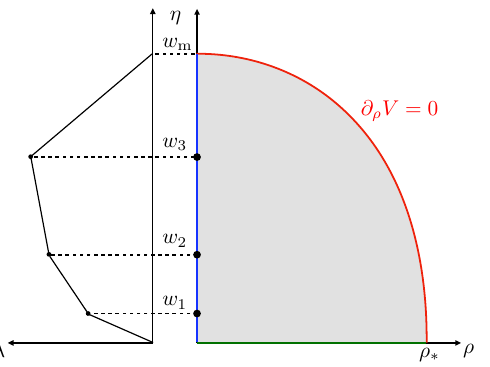
Figure 7. A schematic depiction of the allowed region in the ( ρ, η ) plane, for a case with p = 3 monopoles along the η axis. The arc connecting w by the equation (5.11). On the right, we also include the plot of the charge density λ ( η ) on the interval [0 , w ] m